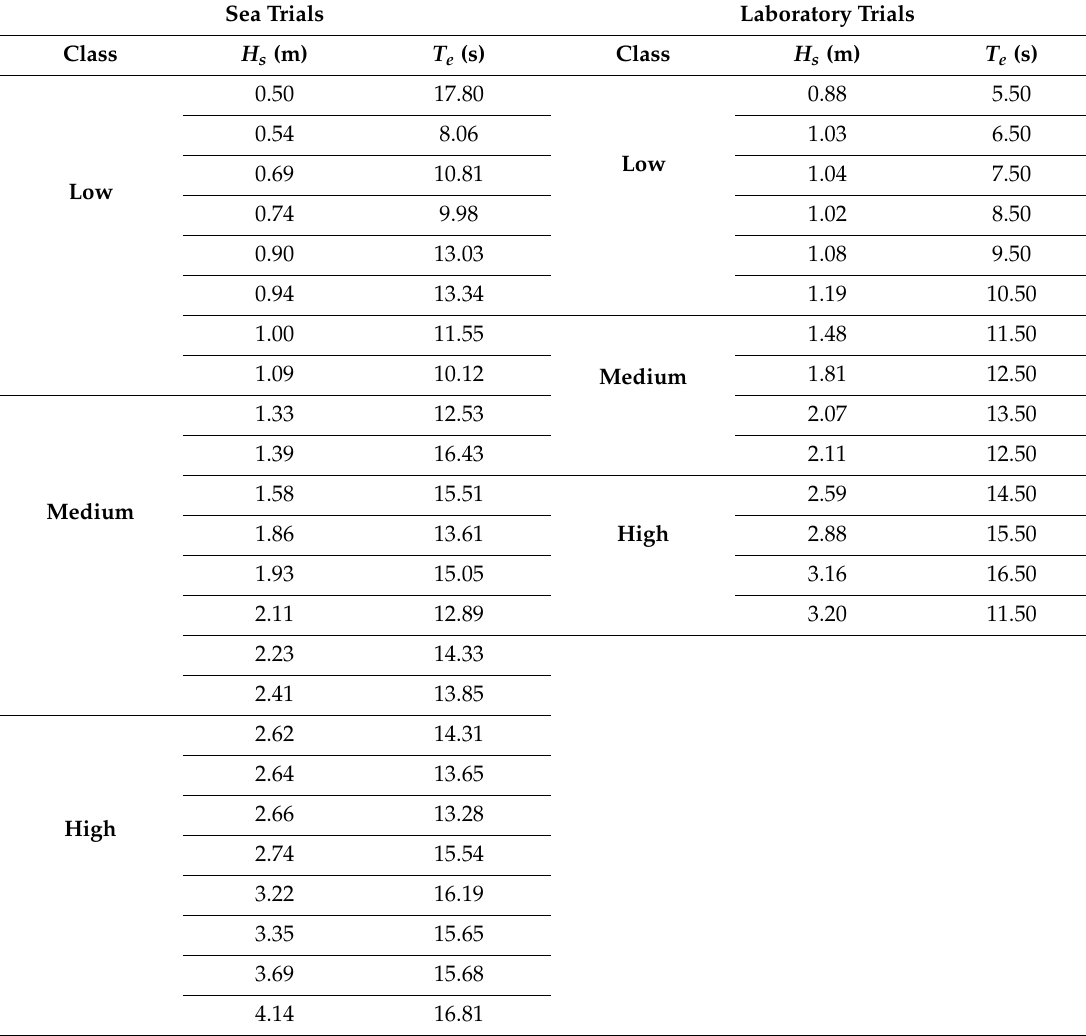
Table 1. Summary sea-state statistics for the datasets analyzed in the